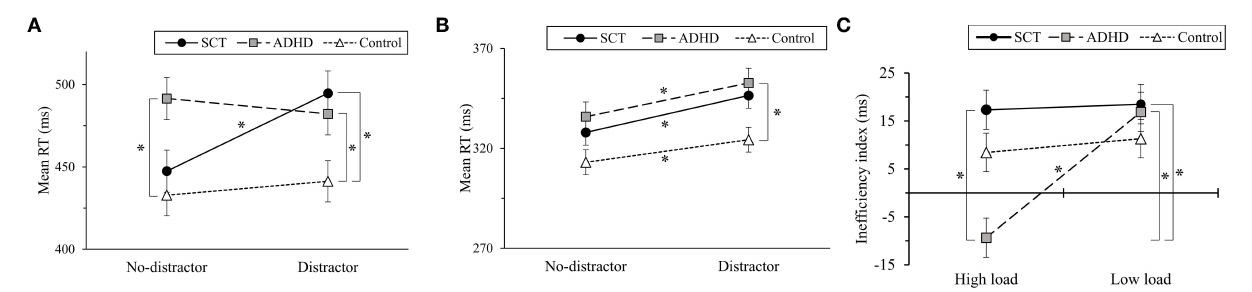
FIGURE 2 | (A) Comparison of mean RT for groups in high load. (B) Comparison of mean RT for groups in low load. (C) Comparison of inefficiency index (distractor cost) for groups in low and high load. Note. High load condition is hypothesized to measure early selective attention. Low load condition is hypothesized to measure late selective attention. Error bars represent standard error of the mean. SCT, sluggish cognitive tempo group; ADHD, attention-deficit/hyperactivity disorder group. No-distractor, no-distractor condition; Distractor, distractor condition; Inefficiency index (distractor cost), RT in distractor condition—RT in no-distractor condition (ms). * p <